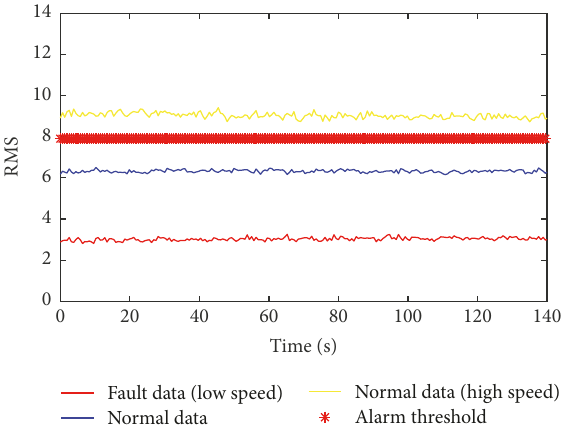
Figure 8: Analysis results of the fixed threshold alarm.